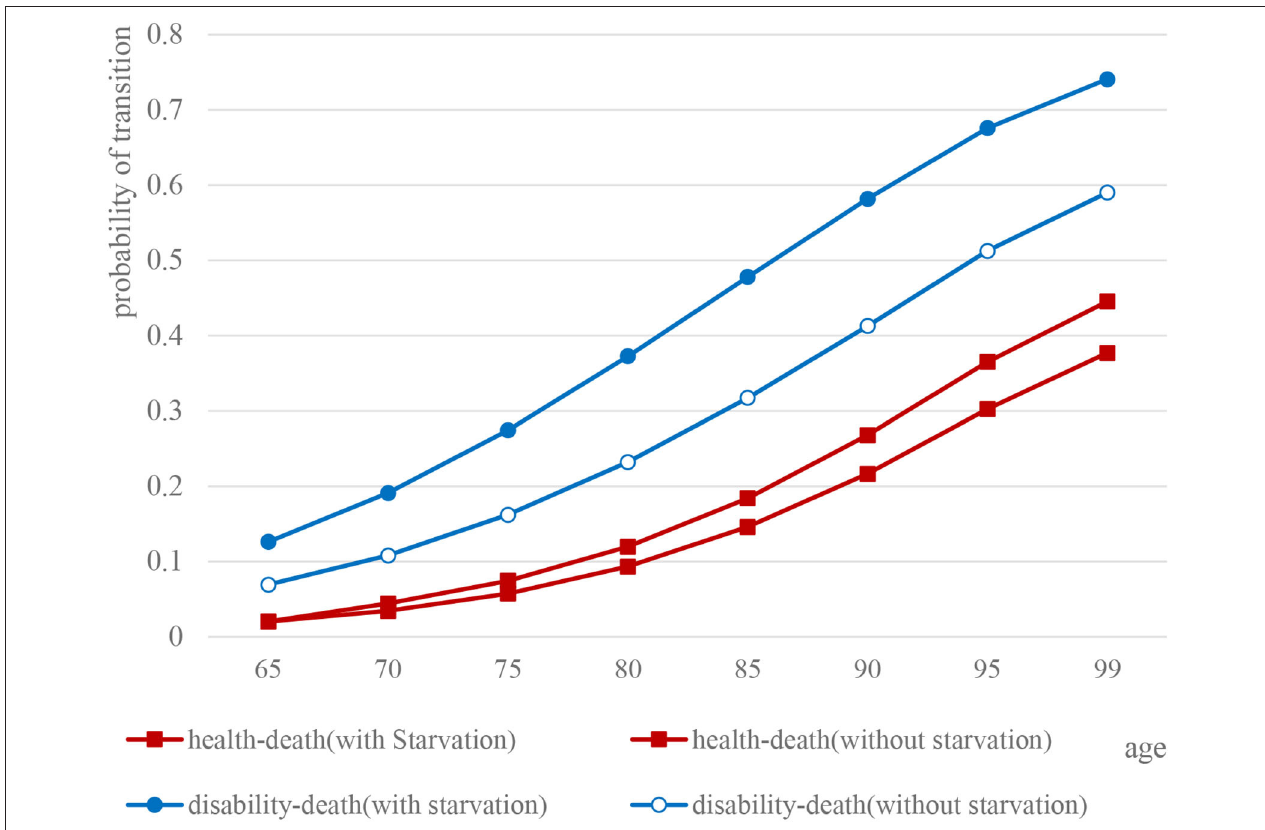
FIGURE 4 | Comparison of health and death transition probability curves of elderly